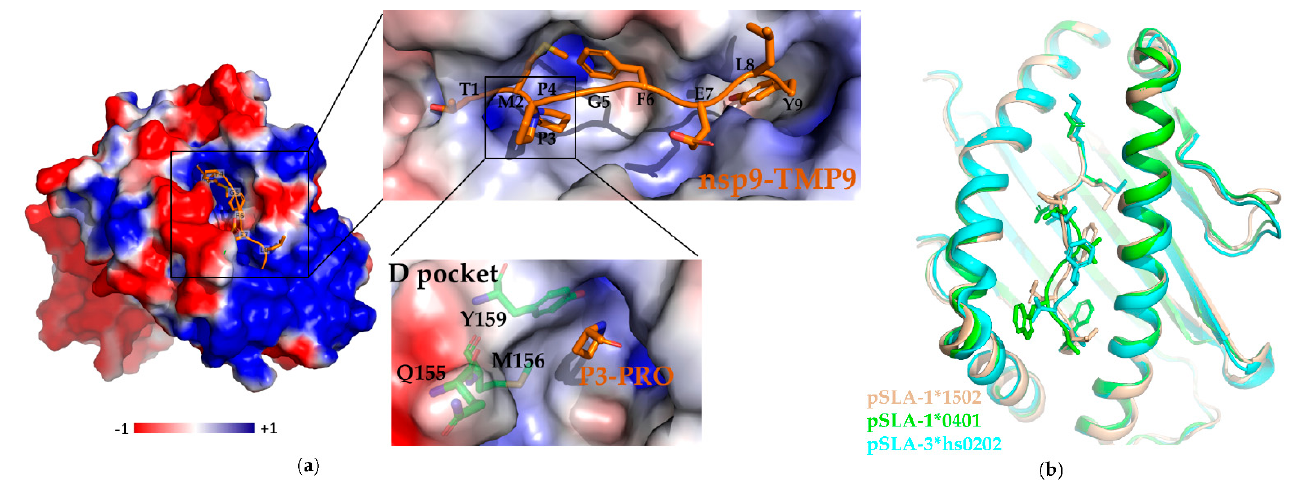
Figure 2. D pocket structure of pSLA-1*1502 bound to nsp9-TMP9 peptide, and comparison of the peptide conformations of the three pSLA structures resolved. ( a ) Overall structure of pSLA-1*1502 complexes with one peptide (nsp9–TMP9) (Protein Data Bank (PDB) code: 5YLX) is represented by electrostatic surface (red, negatively charged; white, non-polar; and blue, positively charged). The nsp9–TMP9 is shown as a stick model (C, orange; N, blue; O, red). The D pocket is shown in particular; P3-PRO represents the third proline residue of the nsp9–TMP9 peptide, and Q155, M156, Y159 residues shown as stick models (C, green; N, blue; O, red) in complexes can interact with the P3-PRO by van der Waals forces. ( b ) The superposition of the pocket structures of pSLA-1*1502 (wheat, PDB code: 5YLX), pSLA-1*0401 (green, PDB code: 3QQ3), and pSLA-3*hs0202 (cyan, PDB code: 5H94) are shown as cartoons. There are slight differences in the conformation of peptides shown as stick models in the three structures.